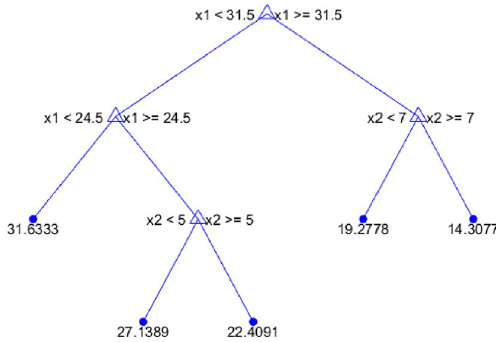
Figure 6. An example of the binary-tree structural model.